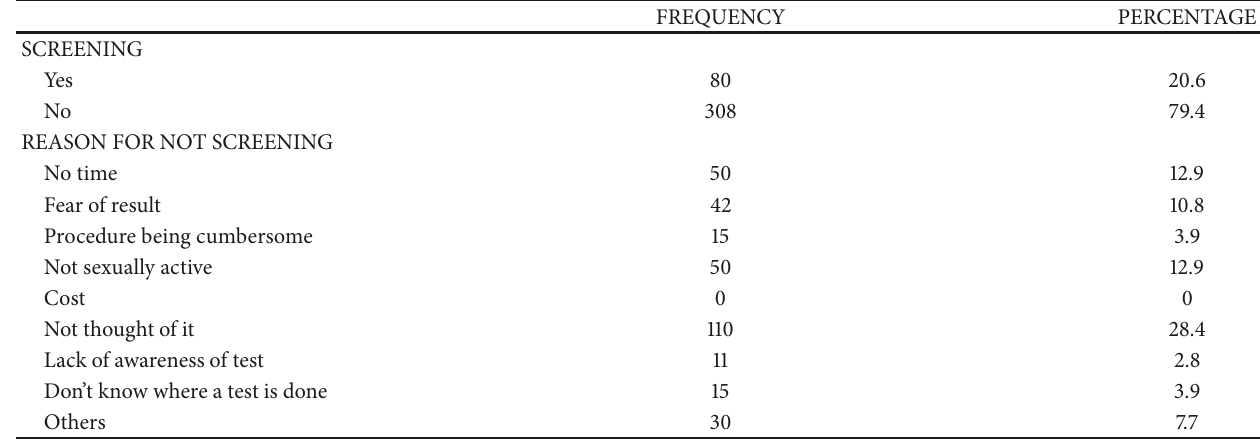
Table 3: Utilization of cervical cancer screening.